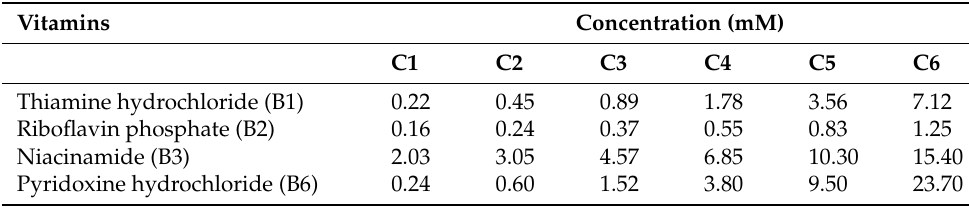
Table 1. Vitamin concentrations used (mM) for the human bitter taste detection threshold.